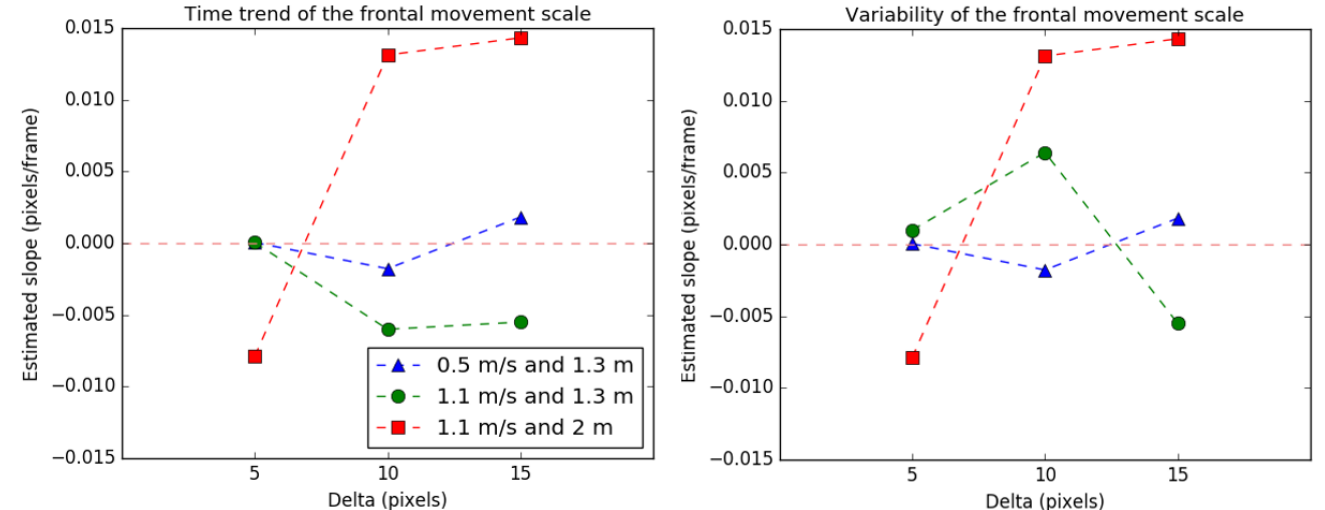
Figure 13. Time trend and variability of the scale for the frontal